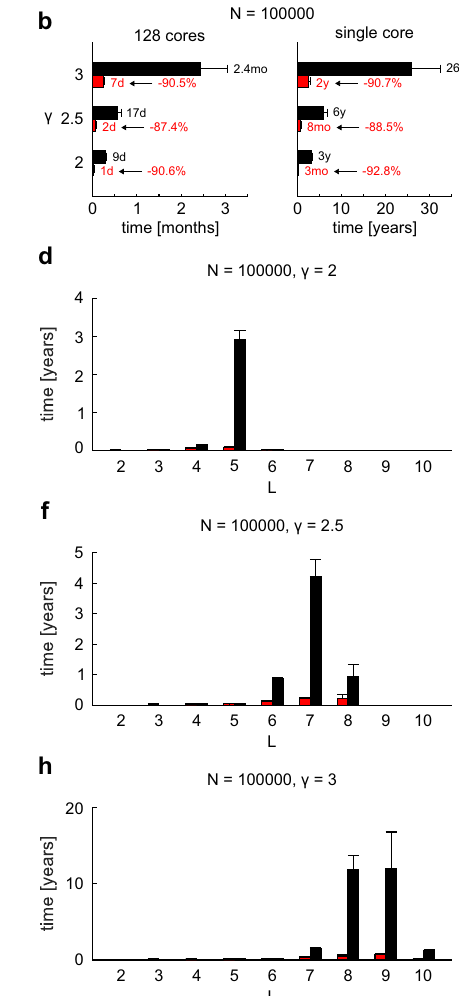
Fig. 5 | Running time estimation. We generated nPSO networks with parameters N = [100,1000, 10,000,100,000], (cid:1) d = 12, T = 0.1, γ = [2, 2.25,2.5,2.75, 3]and C = 4. a The panel reports the running time over increasing network size, both for our algorithm (red) and brute-force (black) using parallel computation, as separate curvesfordifferentvaluesof γ . b Thepanelreports,for γ =[2,2.5,3],theestimated running time with and without parallel computation, both for our algorithm and brute-force, on networks of size N = 100,000. The percent of decrease is shown. c , e , g The panels report, for γ = [2, 2.5, 3] respectively, the proportion of nodes associated with each recursion depth, both for our algorithm and brute-force, on